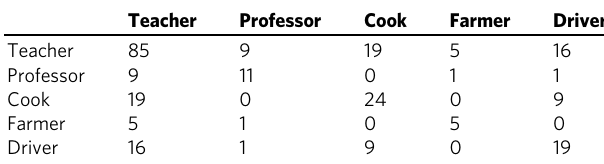
Table 2 Example of a 5 × 5 word-word